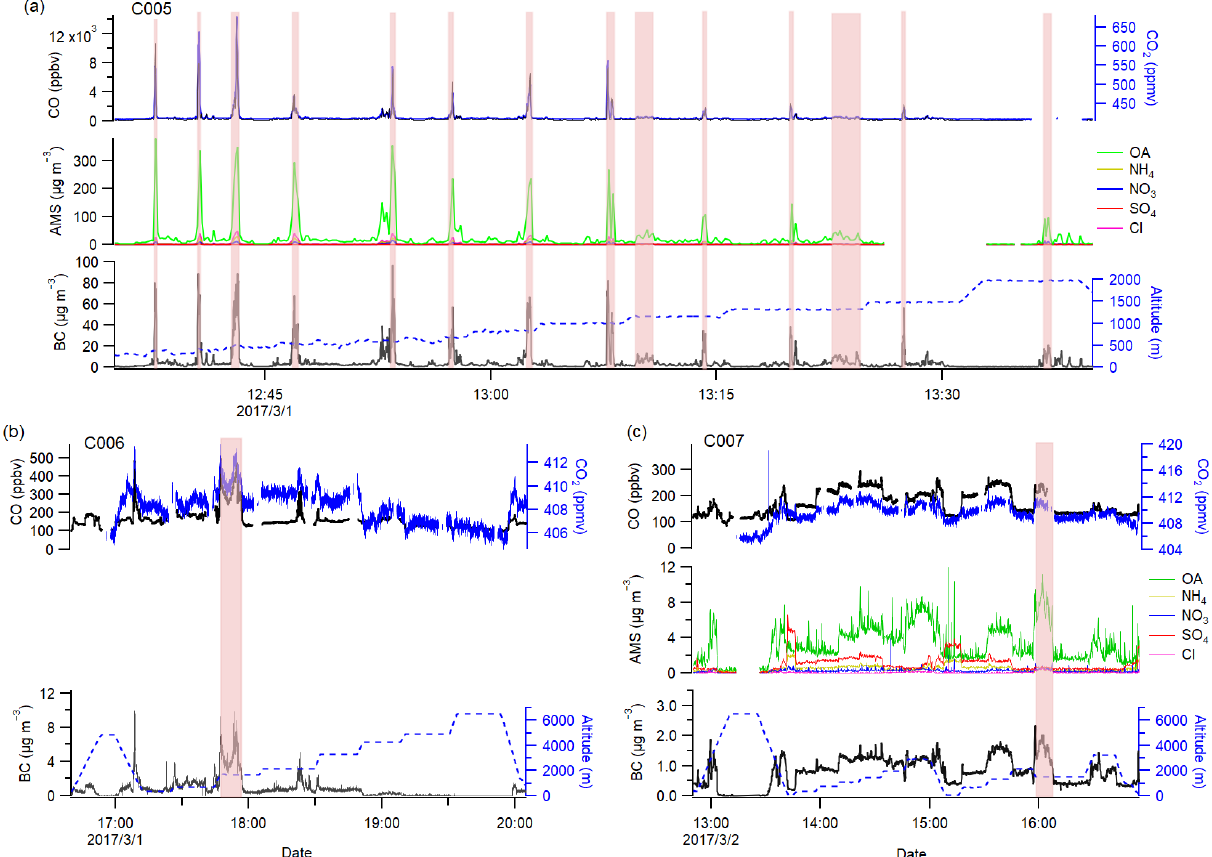
Figure 2. Time series of measured mass concentrations of non-refractory aerosol species from the AMS, BC from the SP2, and also measured CO and CO 2 mixing ratios in each flight ( a for C005, b for C006 and c for C007). The shaded areas are selected smoke plumes at different ages. AMS data for flight C006 are not available as the vacuum pump overheated during this flight. CO was measured using an AeroLaser AL5002 vacuum-UV fast fluorescence instrument, and CO 2 was measured using a fast greenhouse gas analyser (FGGA).